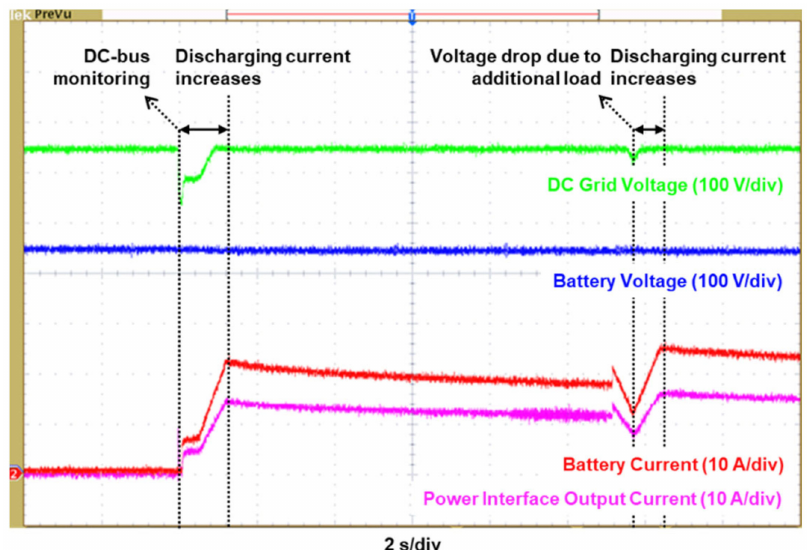
Figure 15. Experimental results of proposed voltage regulation algorithm at undervoltage condition with additional peak load.